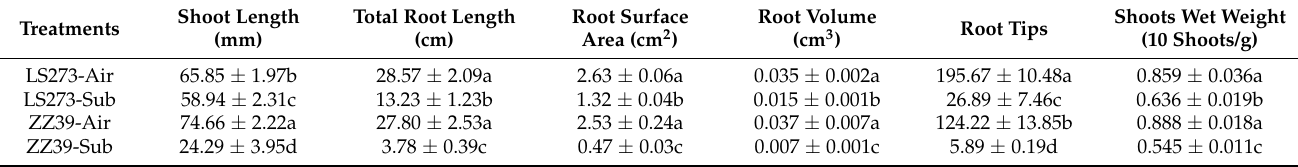
Figure 1. Morphological characteristics of the LS273 and ZZ39 cultivars during shoots growth under normal and flooded conditions. ( A ) Phenotypic difference between LS273 and ZZ39 on 9 days. ( B ) Growth dynamics of seedling height in LS273 and ZZ39. ( C ) Root scanning diagram of ZZ39 and LS273 (resolution 300 ppi). ( D ) Schematic diagram of flooding identification equipment: (1) Flooded box, (2) root shading box, (3) open-well PCR plate, (4) upper platen. LS273-Sub: LS273 flooding treatment; ZZ39-Sub: LS273 flooding treatment; LS273-Air: LS273 blank control; ZZ39-Air: ZZ39 blank control. Table 1. Submergence stress affects the phenotype of rice of different resistances.